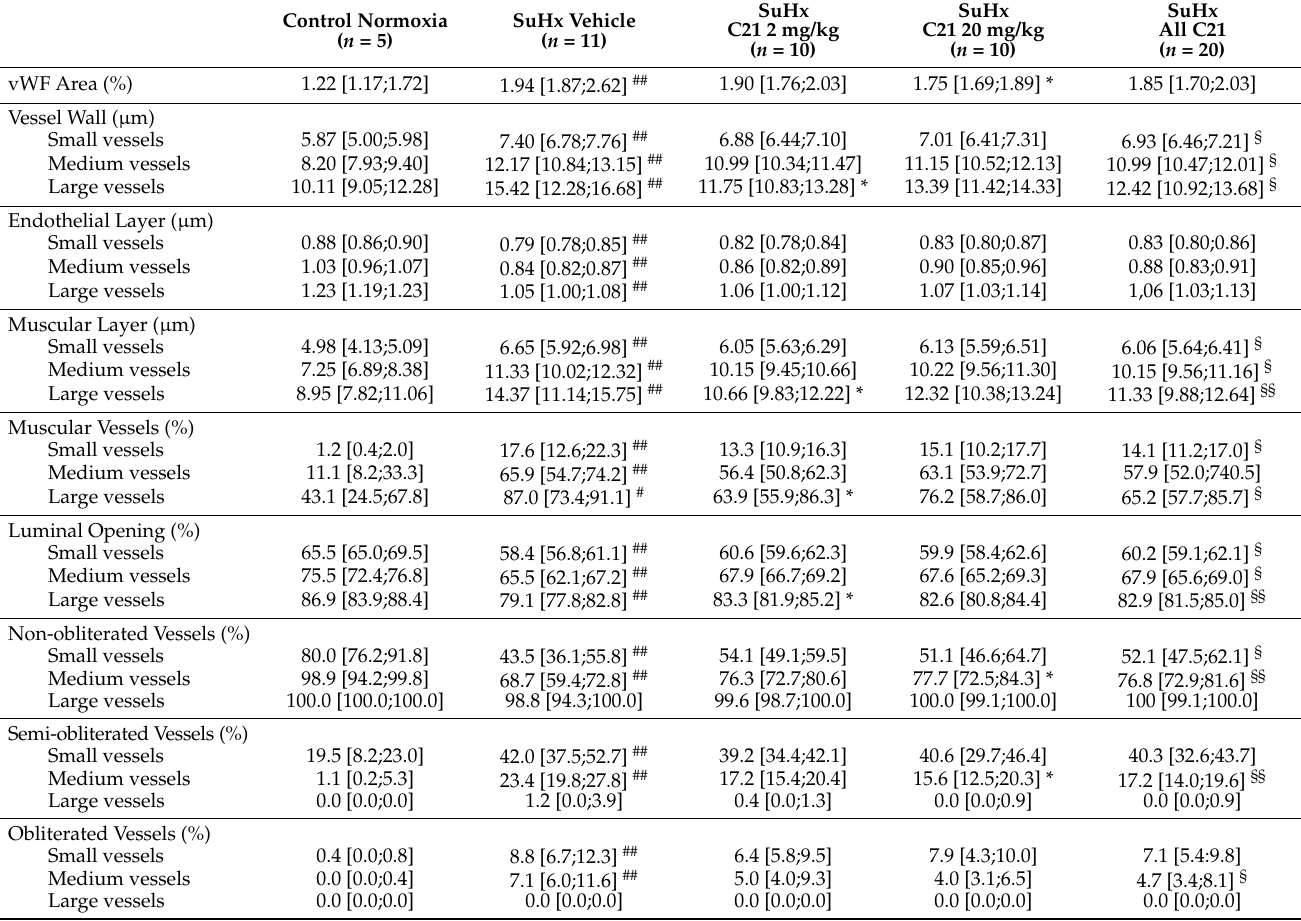
Table A3. Assessments of vasculopathy in the lungs of rats exposed to Sugen-hypoxia. Control Normoxia ( n = 5)